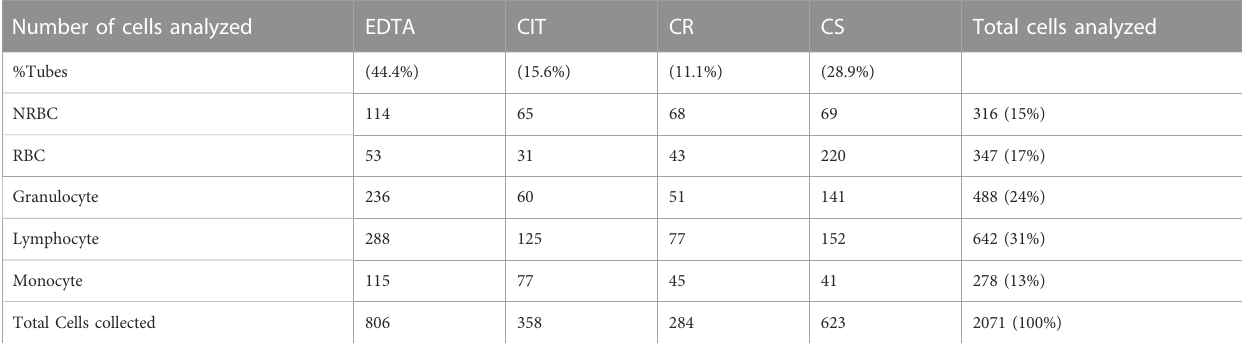
TABLE 2 Number of collected cells for each condition. Percentages refer to the total amount of cells analyzed.